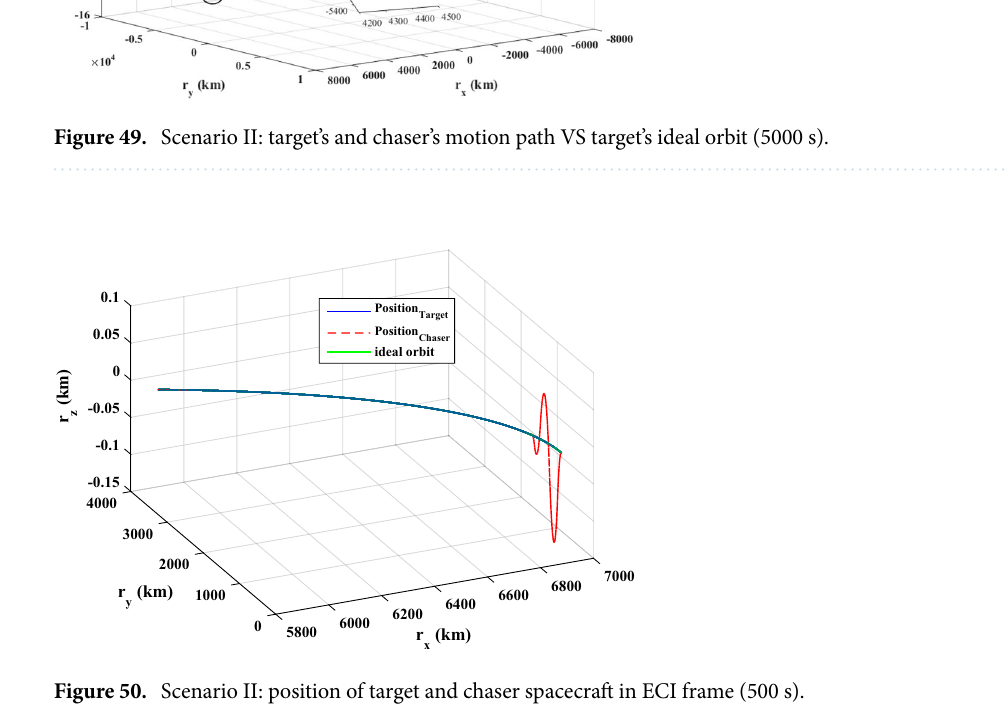
Figure 50. Scenario II: position of target and chaser spacecraft in ECI frame (500